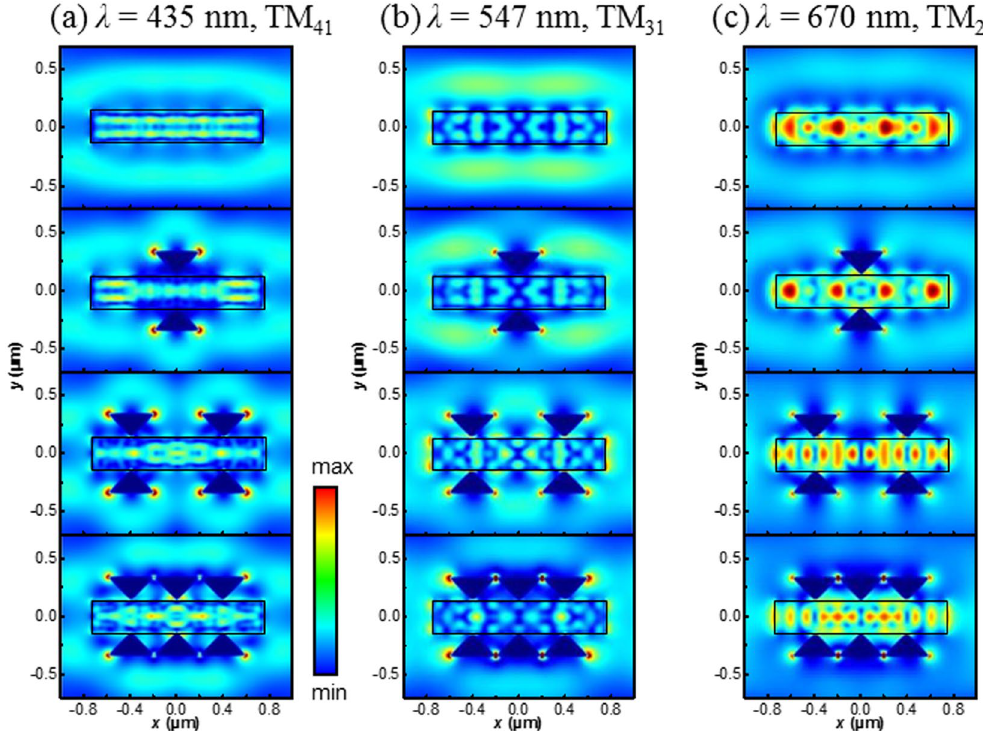
Figure 7. Calculated electric near-field distribution of the NW-antenna systems with TM polarized light across the NW plotted in the horizontal plane of the device. ( a )–( c ) Show the electric field intensity for the wavelength of 435 nm (TM 41 ), 547 nm (TM 31 ) and 670 nm (TM 21 ) for NW with and without bowtie antennas,